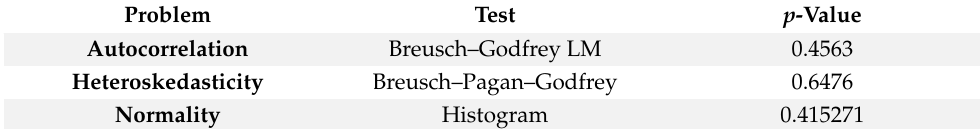
Table 8. Diagnostics test.